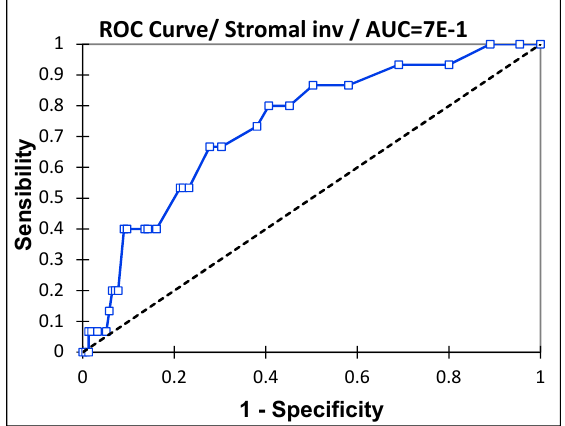
Figure 1. A Receiver Operating Characteristic (ROC) curve showing the association with stromal invasion and the presence of low-volume metastasis.